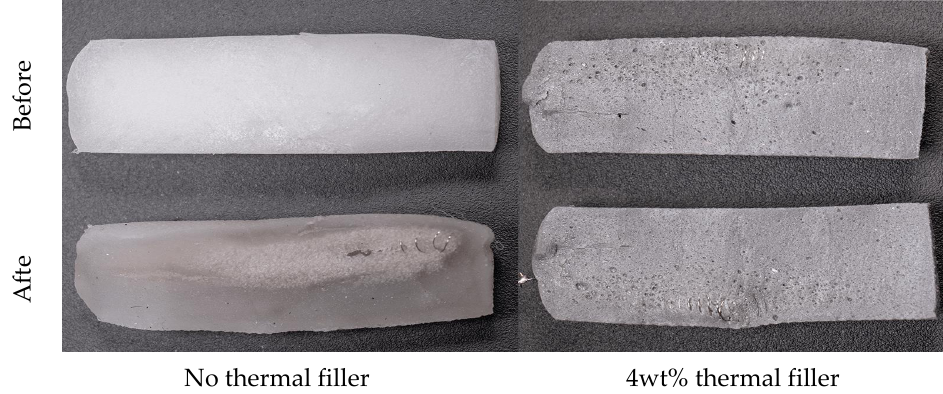
Figure A2. Comparison of a “plain” (0 wt.% filler) material-actuator cross-section to that of the 4 wt.% thermal filler specimen—before and after actuation.